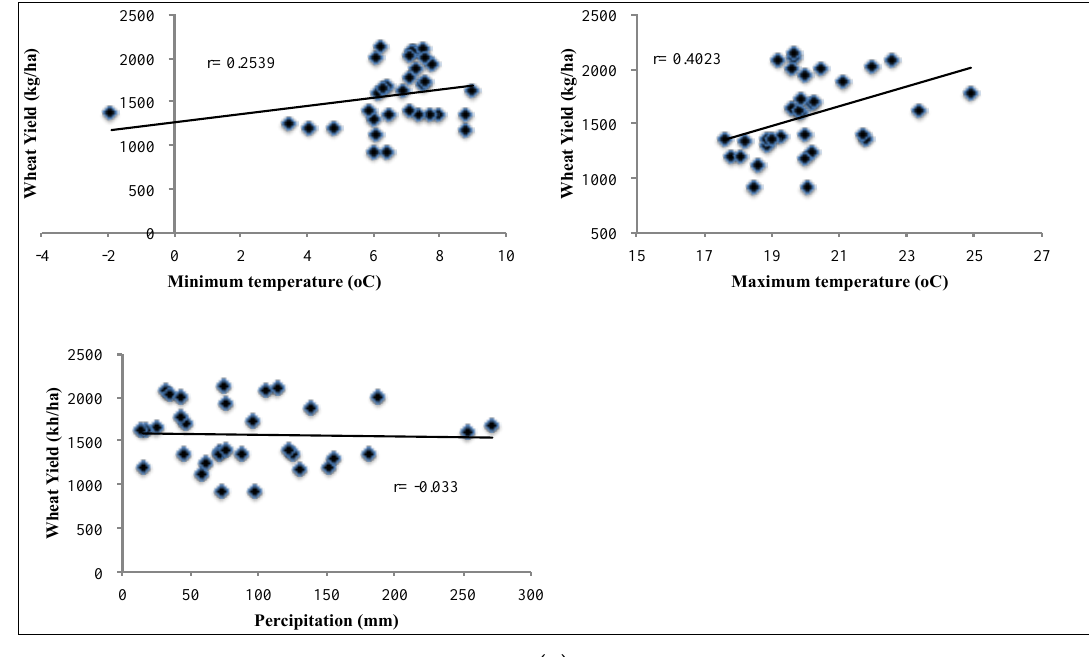
Figure A1. Correlation of rice, maize, millet, barley and wheat with maximum temperature, minimum temperature and corresponding seasonal accumulated precipitation. ( a ) Correlation of rice with maximum temperature, minimum temperature and precipitation. ( b ) Correlation of maize with maximum temperature, minimum temperature and precipitation. ( c ) Correlation of barley with maximum temperature, minimum temperature and precipitation. ( d ) Correlation of millet with maximum temperature, minimum temperature and precipitation. ( e ) Correlation of wheat with maximum temperature, minimum temperature and precipitation.